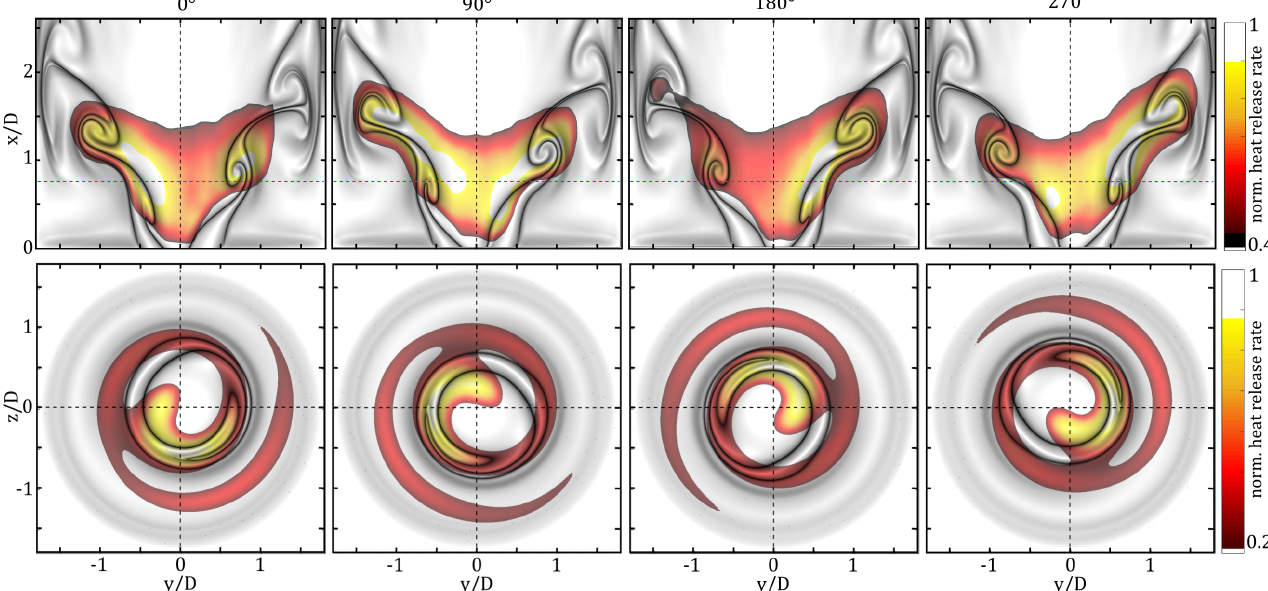
Figure 1. Precessing vortex core (PVC) mode and flame dynamics reconstructed from time-resolved particle image velocimetry (PIV) and OH*-chemiluminescence snapshots revealing PVC-induced vortices (gray-scale) overlaid with heat release rate indicating the corresponding variation in the flame. Top row: phase-averaged heat release rate fluctuations in longitudinal section; bottom row: PVC-induced heat release rate fluctuations in cross-sectional view (x/D = 0.75). Heat release rate is normalized to maximal